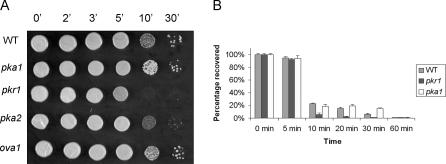
Comparison of Heat Shock Sensitivity for the WT Strain, and the pka1 and pkr1 Mutants(A) Cells (105) were subjected to heat shock treatment at 50 °C for the indicated time and spotted on YPD plates. The plates were incubated for 3 d at 30 °C.(B) Enumeration of colony forming units (CFUs) for the strains after heat shock. The data are expressed as the percent of the starting number of cells recovered after heat shock and represent the mean values ± standard deviation (SD) from three independent experiments.